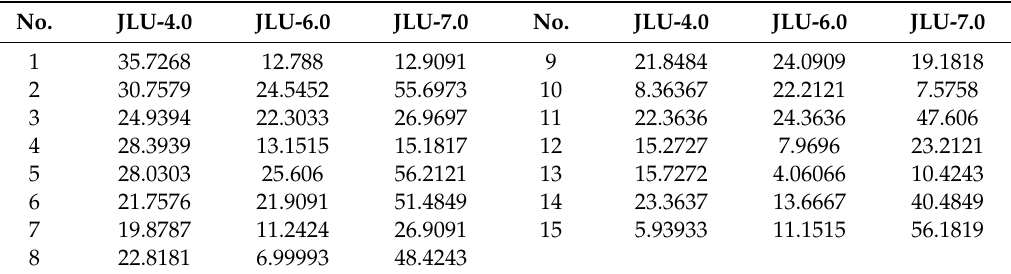
Table 10. The recognition parameters of the training iris of the example.